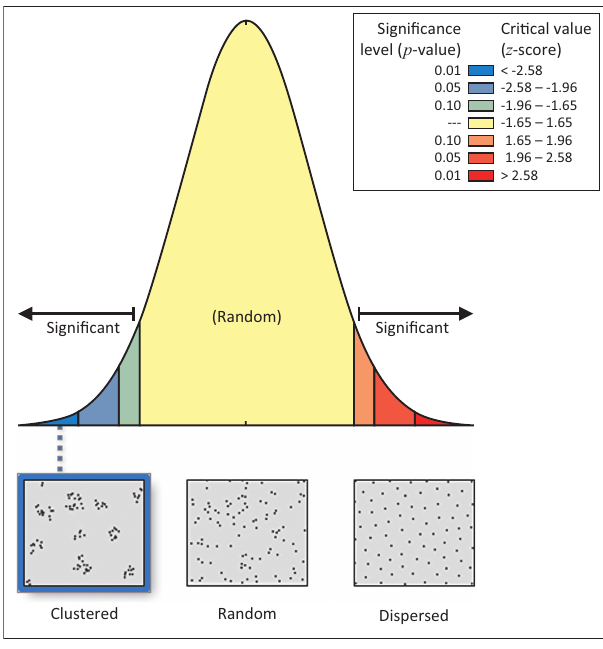
FIGURE 9: Report of high–low clustering analysis generated on substation